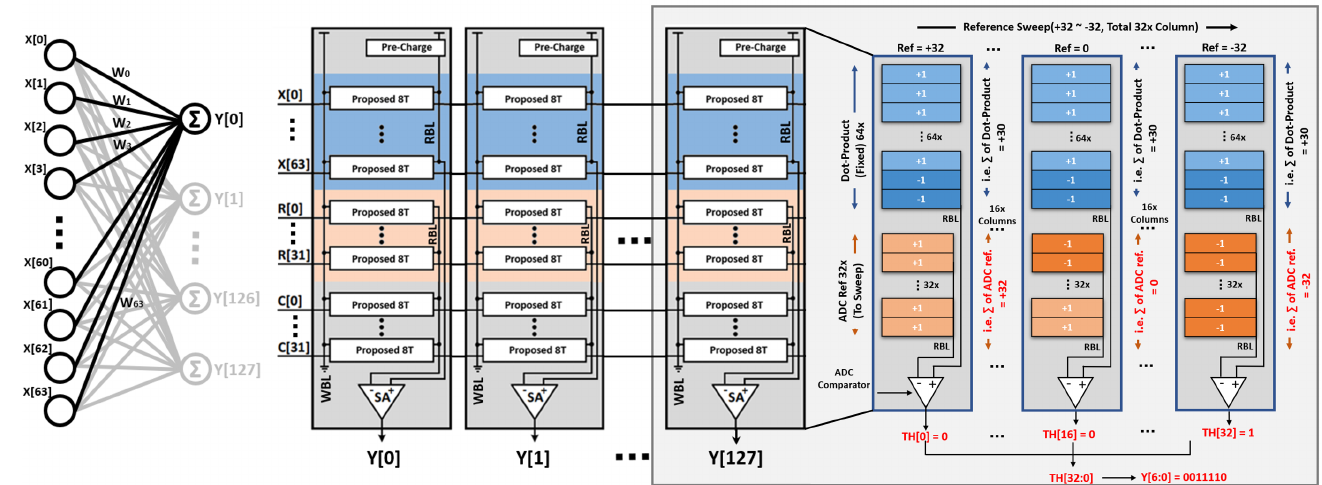
Figure 3. ( left ) A schematic diagram of the proposed column-based SRAM-CIM corresponding to the fully-connected layer. (64 × input and 128 × neurons) ( right ) Structure of column ADC (64 × input for 7-bit output).